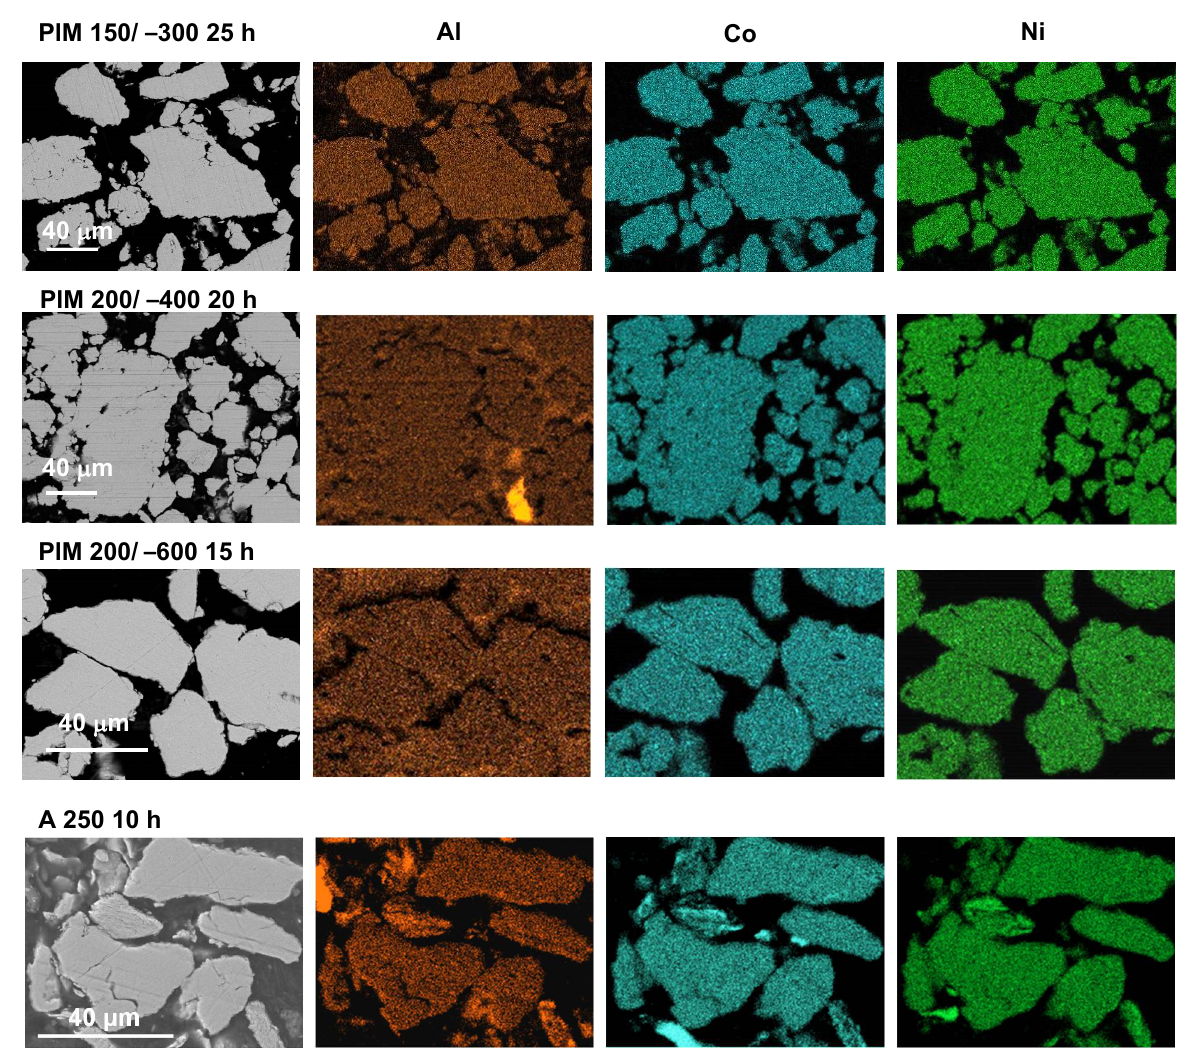
Figure 3. Element distribution in Ni 36 Al 27 Co 37 MA-powders at various MA modes and time of milling in the planetary mill (PlM) and in the attritor (A).